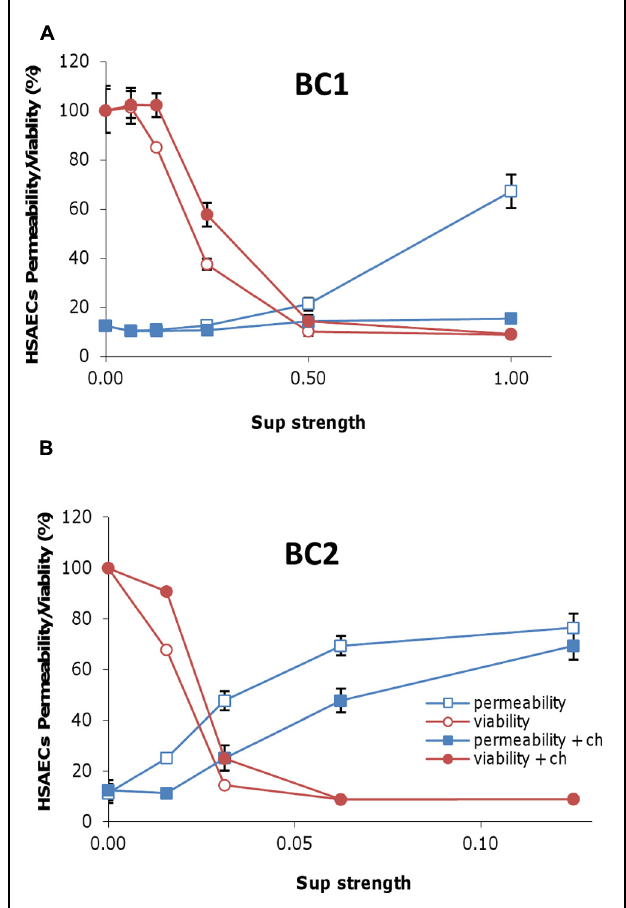
FIGURE 3 | The activity of Sups results in cell membrane damage of the exposed HSAECs. Sups from microaerobic cultures of BC1 (A) and BC2 (B) in DMEM supplemented with 1 g L − 1 of BSA were serially diluted with fresh medium and incubated with 10 μ g mL − 1 of cholesterol (ch) for 1 h at room temperature. Then 100 μ l of Sups at the indicated dilutions were added to the monolayers of HSAECs and incubated for 20 min. The cell membrane permeability was assessed with the CytoTox-ONE Homogeneous Membrane Integrity kit (Promega) based on the release of LDH. Toxicity toward HSAECs was analyzed using resazurin. The viability and permeability corresponding assays were calculated as fluorescence relative to the untreated control or completely lysed cells,